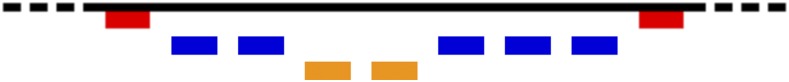
A specific example of three layers of nesting. The two MIC loci for MAC contigs Contig9583.0 (blue) and Contig6683.0 (orange) are nested between Contig6331.0 (red) on the micronuclear contig ctg7180000067077. Not drawn to scale. The red locus has an IDI of 2, the blue locus 1, and the orange locus 0.